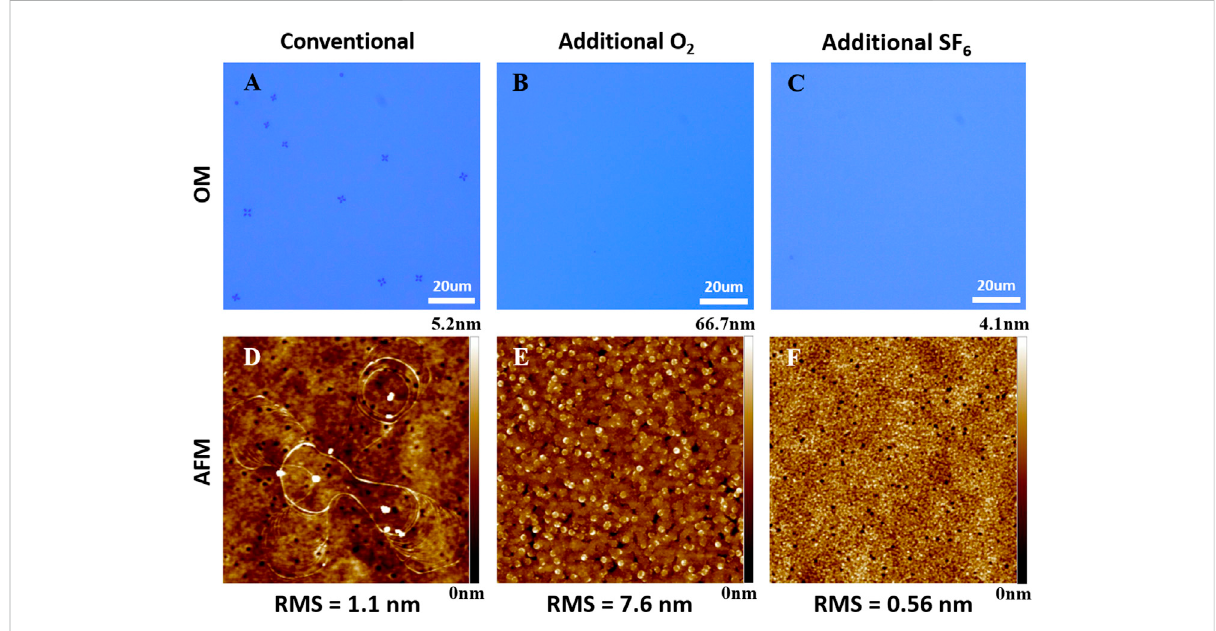
FIGURE 6 OM images of the surfaces with (A) Conventional and (B) Additional O 2 and (C) Additional SF 6 etching after the etching stopped at the Al